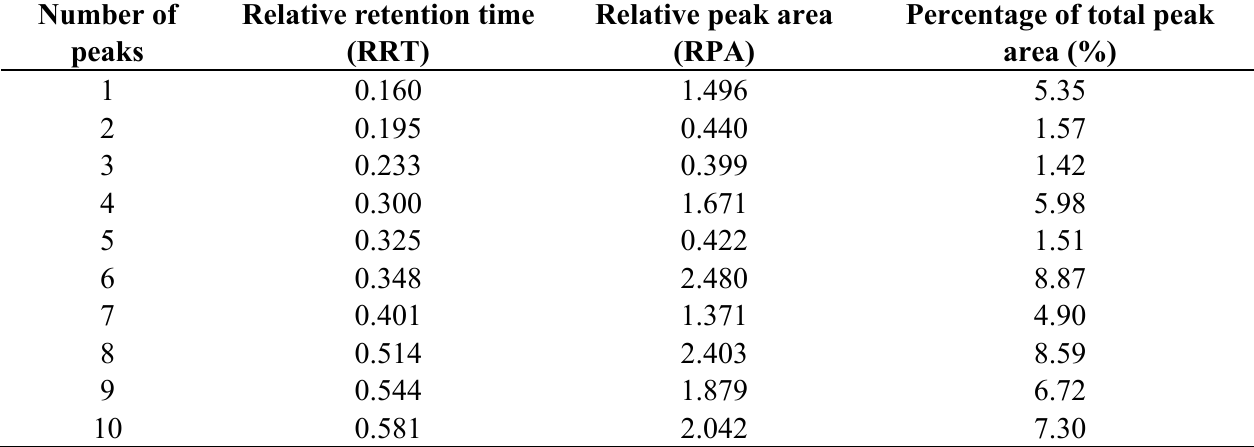
Table 1. Relative tR and relative peak area of peaks in A. capillaris